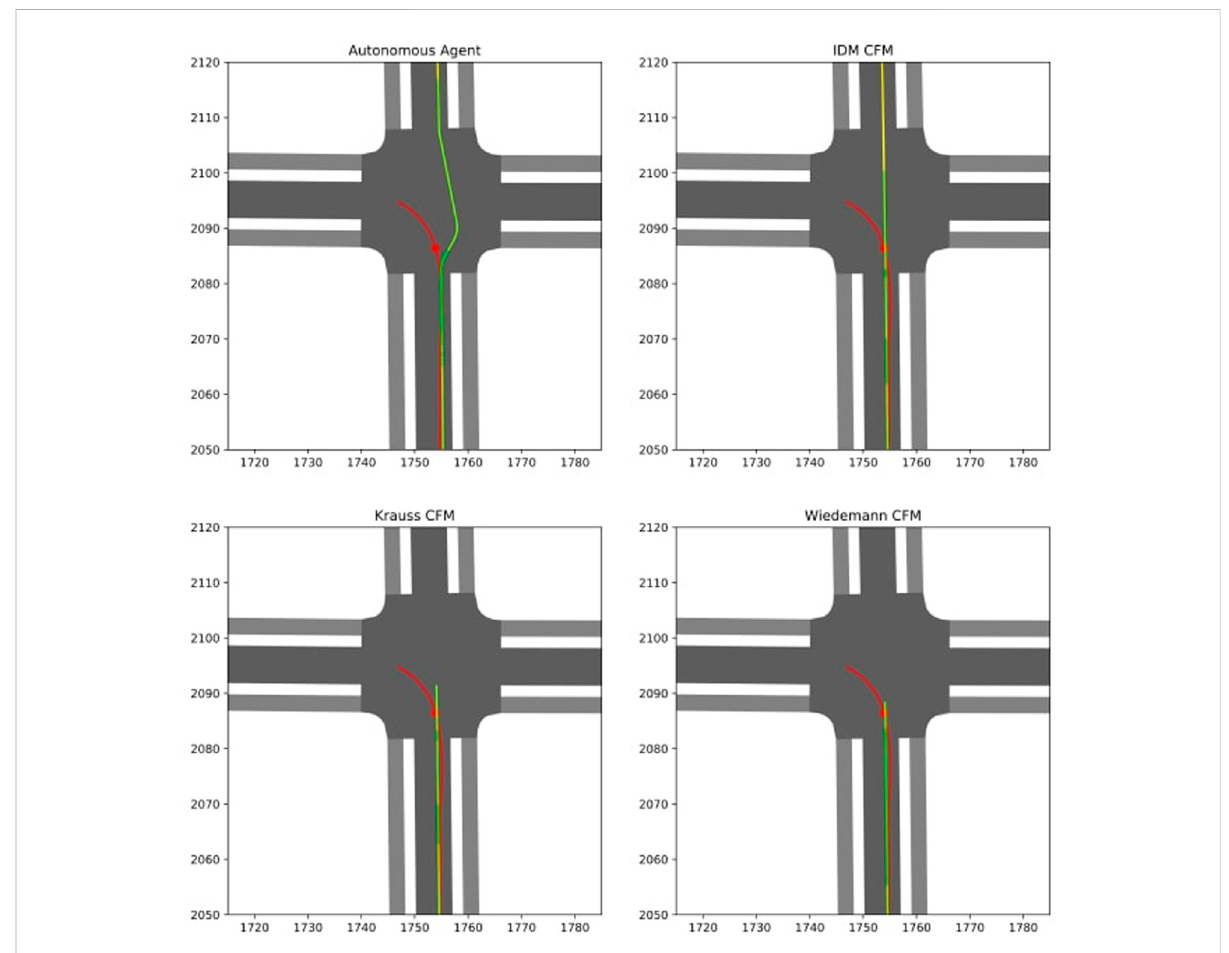
FIGURE 12 The trajectories of the autonomous agent in comparison to the other car models scenario